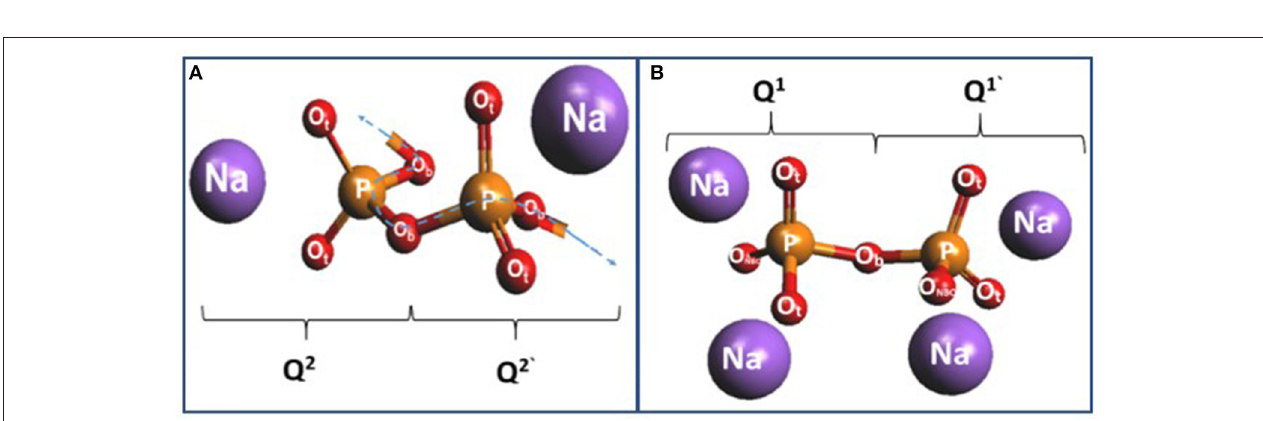
FIGURE 13 | The observed LO and TO mode frequency variation with glass composition for the Q 2 asymmetric mode (A) and the Q 3 asymmetric mode (C) in (Na 2 O) x (P 2 O 5 ) 100 − x glasses ( Figure 4 ) in the 30% < x < 60% range. The frequency difference ν LO − ν TO displays a broad minimum in the IP (B) for the Q 2 asymmetric mode and (D) for the Q 3 asymmetric mode. The reduction in LO–TO splitting or internal Electric fields in the IP could be the consequence of the absence of network stress and network compaction that leads to a redistribution of charges in these ionic